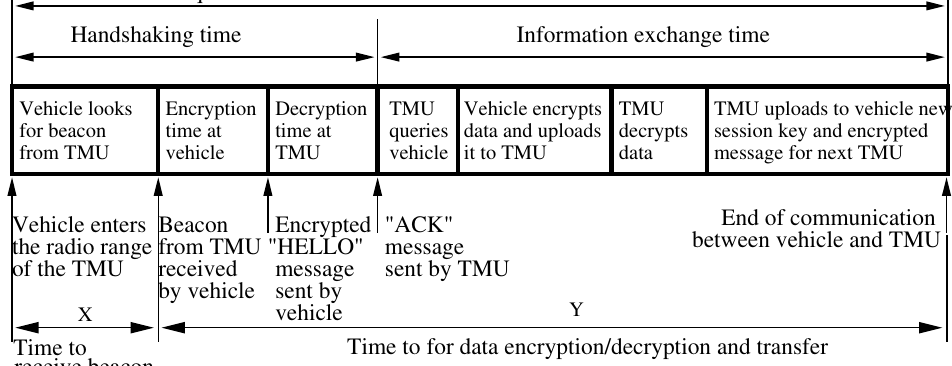
Figure 3. Illustrating the details of vehicle to TMU communication [85]